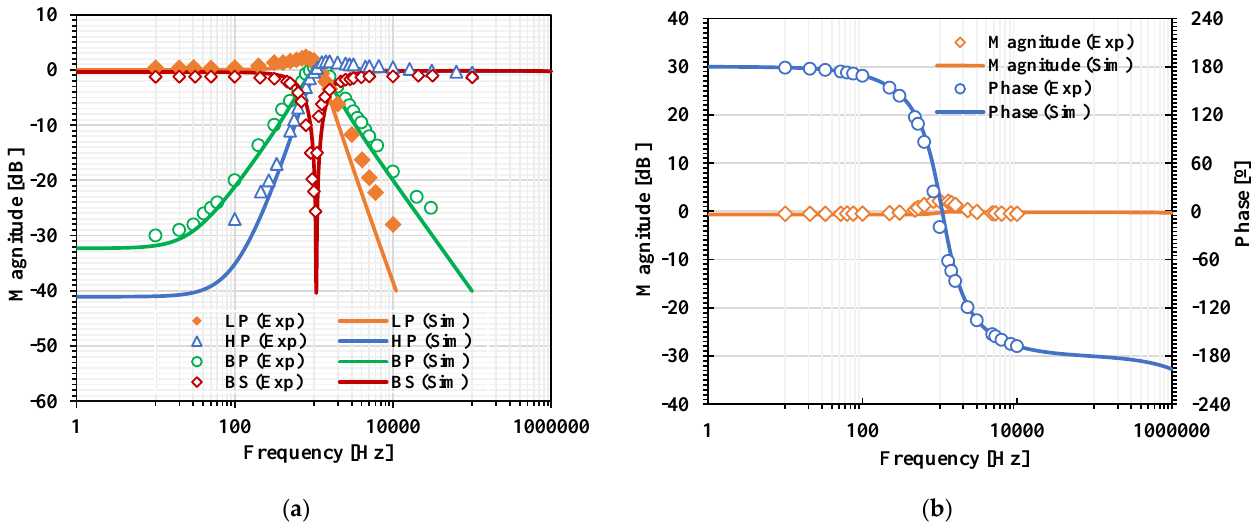
Figure 17. Experimental frequency responses of the VM filter: ( a ) LP, BP, HP, BS filters; ( b ) AP filter.